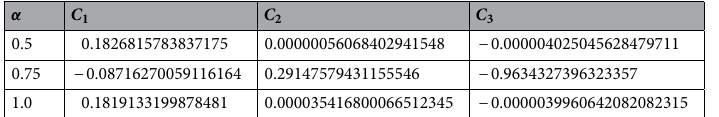
Apply the inverse operator, I α , with initial condition to (25), we have the following solution